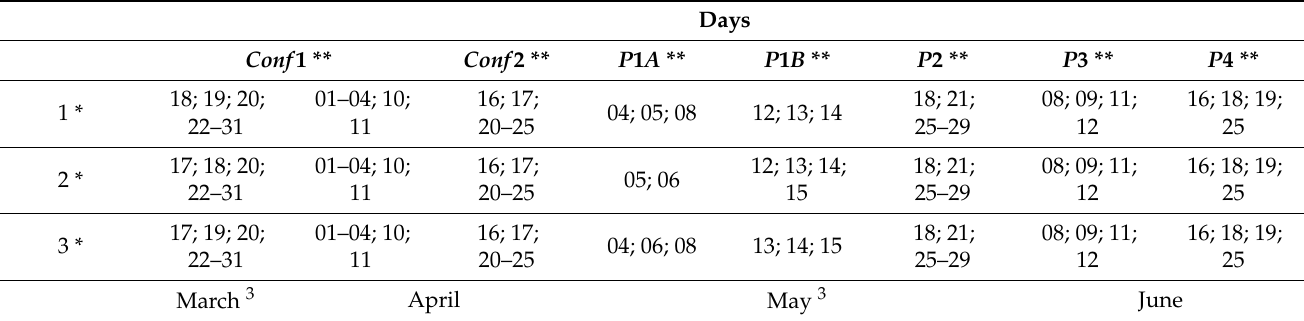
Table 1. Measurement campaign of PM 2.5 concentrations around urban